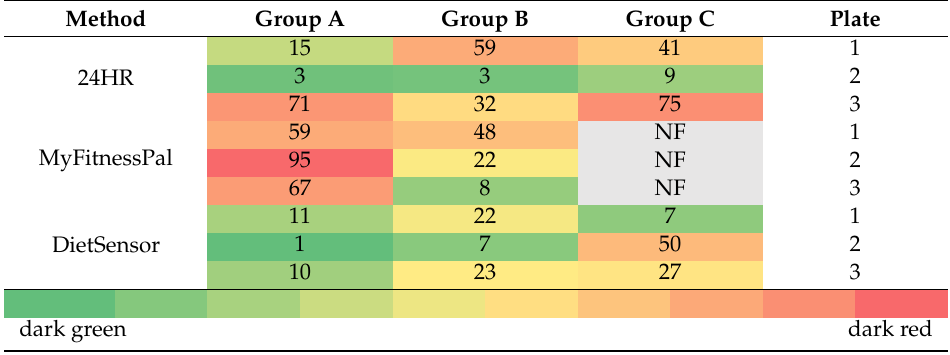
Table 2. A subset of data from Table 1 taken to highlight variation in absolute error in grams (g) between each method, depending on the user groups (A, B, and C). Group C users were not made to use MyFitnessPal (under the assumption that they are not aware of any information about the plate). These cells have been labeled NF (Not Found). The rows are marked by the plate consumed, and the values are color-coded with lower errors colored dark green, and larger errors colored dark red. Method Group A Group B Group C Plate